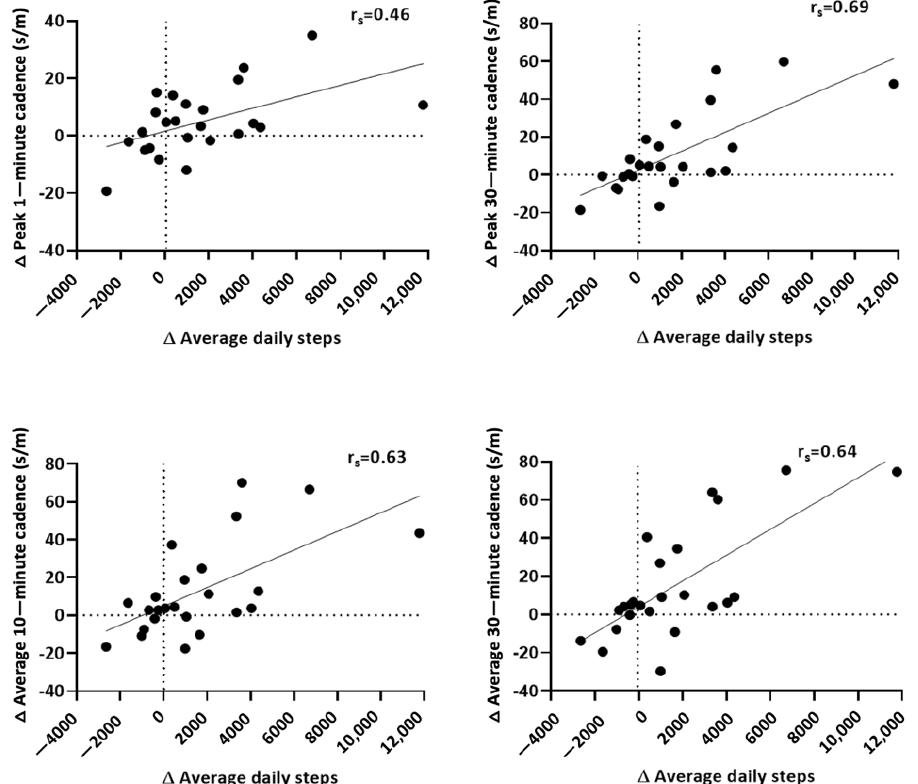
Figure 2. Correlation between change in average daily steps and change in cadence values (upper left: peak 1—min cadence; upper right: peak 30—min cadence; lower left: average 10—min cadence; lower right: average 30—min cadence). Solid circles represent Intervention group